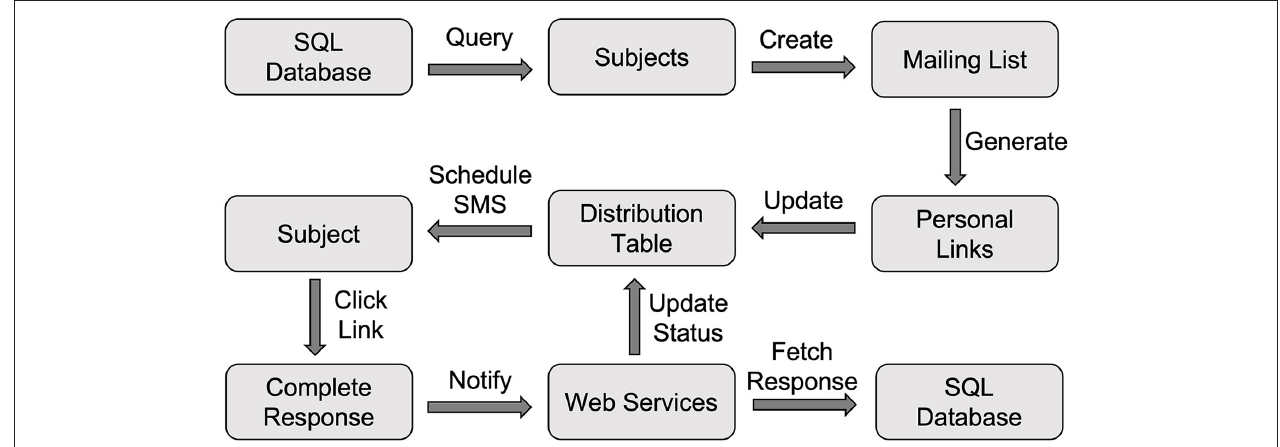
FIGURE 3 | The Workflow of conducting EMA using Qualtrics. EMA, Ecological Momentary